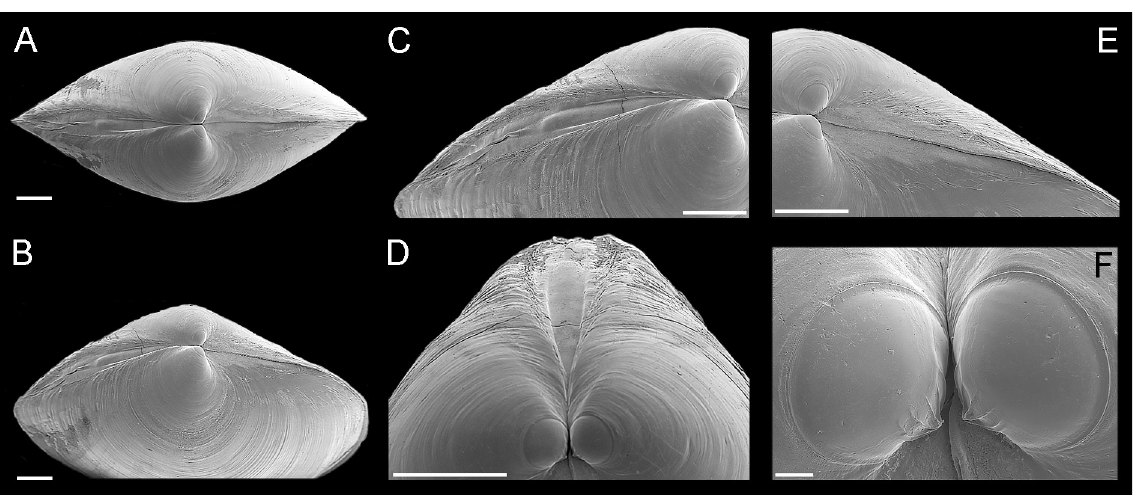
Fig. 4. Scanning electron micrographs of Parathyasira coani sp. nov. (MIMB 43819). A–B . Dorsal and oblique dorsal views of both valves. C–E . Dorsal and oblique views of posterodorsal and anterodorsal shell margins showing escutcheon and lunule. F . Prodissoconchs. Scale bars: A–E = 500 µm; F = 50